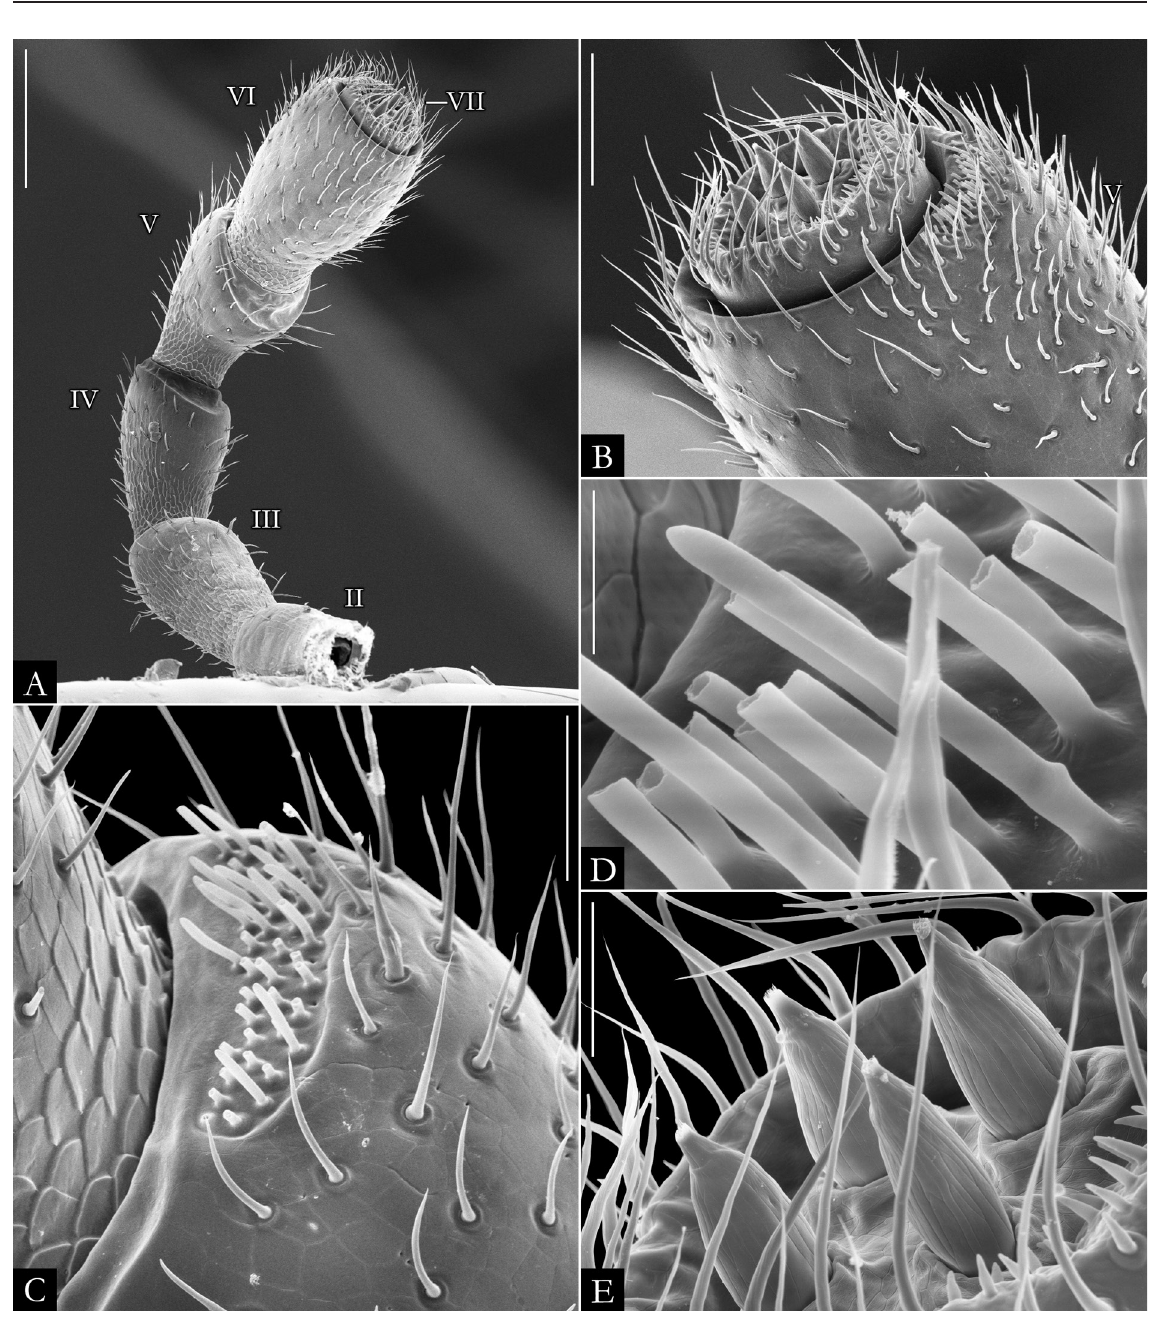
Fig. 22. SEM images of the antenna of Pseudonannolene spelaea Iniesta & Ferreira, 2013 (IBSP 6071). A. Antenna, in mesal view. B. Lateral view of antenna. C. Detail of antennomere V. D. Detail of the baciliform setae on antennomere V. E. Detail of sensory cones. Scale bars: A = 0.25 mm; B = 0.1 mm; C, E = 0.05 mm; D = 0.01